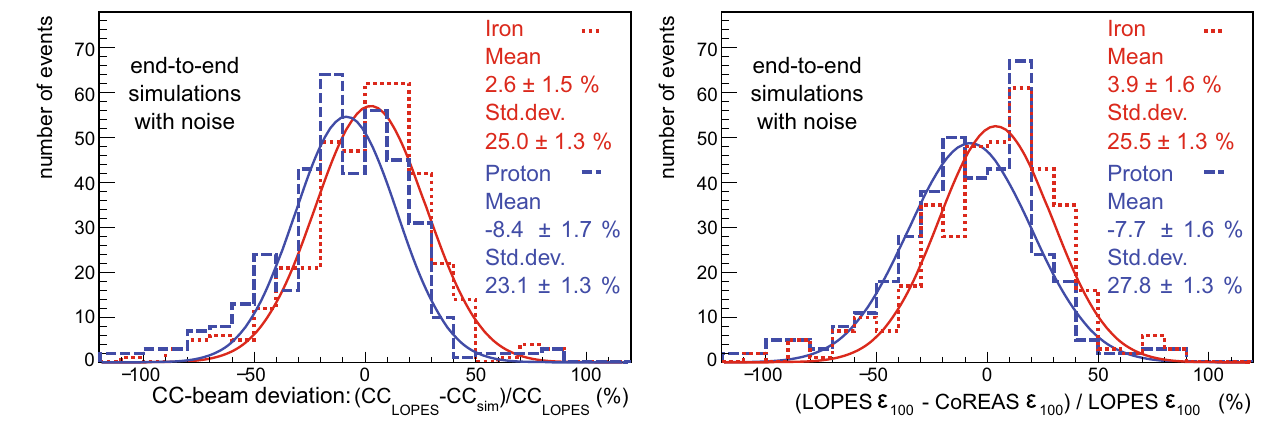
the shower axis as determined by a fit of the lateral distribution (for east-west antennas). The stated values are from a Gaussian fitted to the